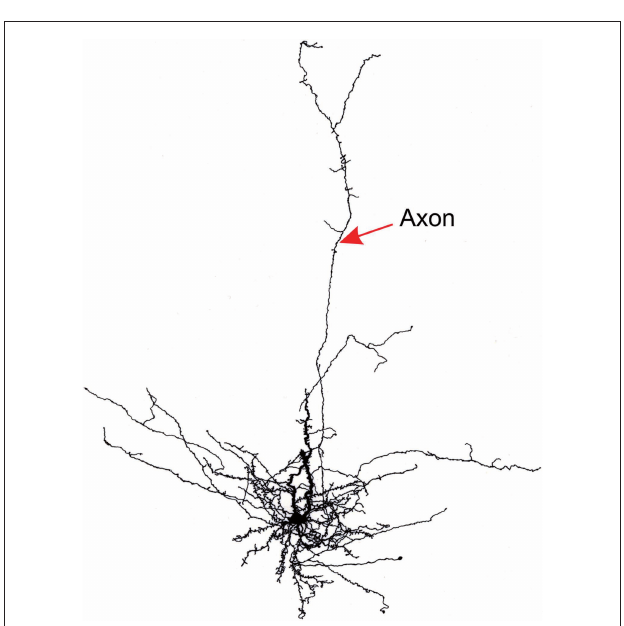
FIGURE 3 | NOS positive neurons in WM and SP. (A,B) Photomicrographs of white matter and subplate area in visual cortex from tissue obtained from human brain (after tissue resection for epilepsy surgery) from a young (3 years of age) and an older (40 years of age) subject and (C,D) from adult rat (42 days postnatal) visual cortex where tissue has been processed for NADPH diaphorase histochemistry. All photomicrographs are oriented with the cortical surface to the right. The human tissue shows numerous white matter neurons that are